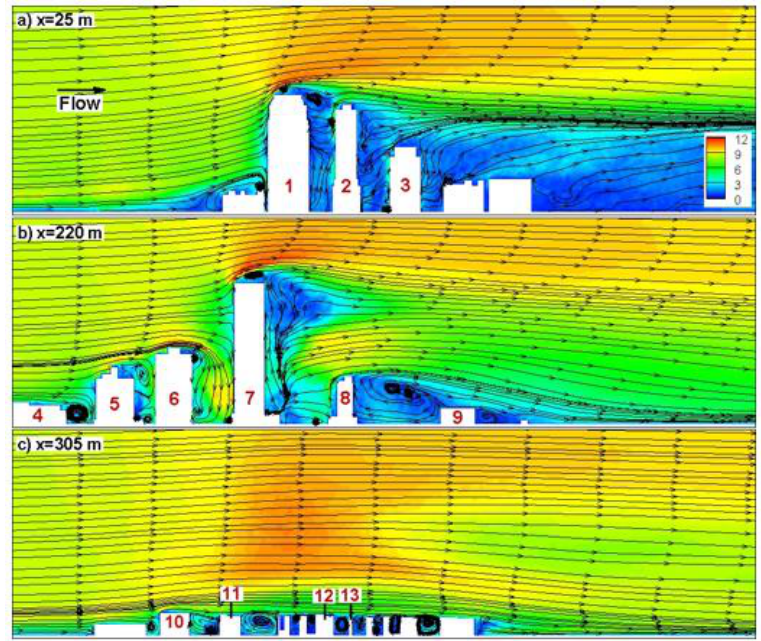
Figure 3. 2D streamlines and velocity magnitude contours at ( a ) x = 25 m; ( b ) x = 220 m; ( c ) x = 305 m planes (see the location of planes in Figure 2).